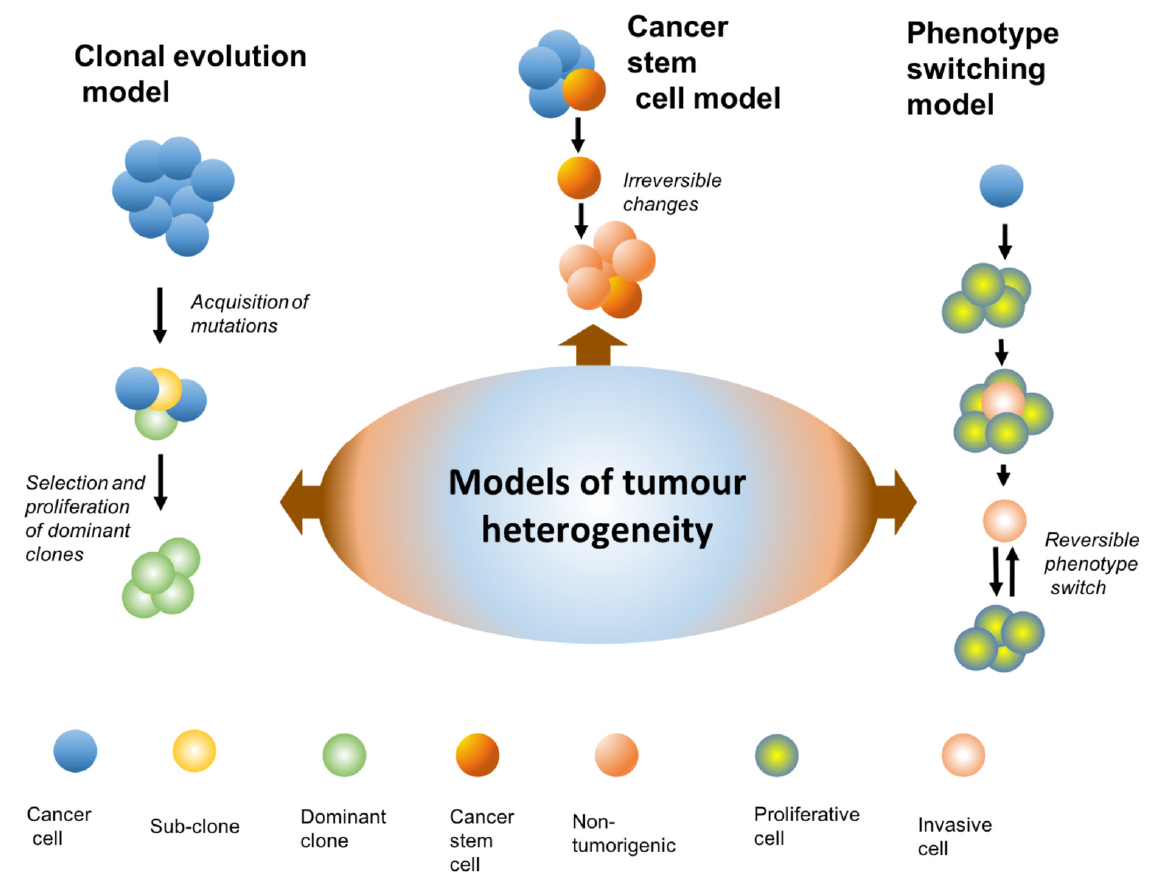
Figure 4. Models of the tumour heterogeneity. The clonal evolution was the first model. In this model the cancer cells evolve progressively due to genetic changes. The genetic instability produces many variants. Most variants die due to metabolic or immunologic disadvantage. The variants that have a selective advantage become the dominant sub-population until an even more favourable variant appears. Over time there is sequential selection of sub clones through evolutionary selection. The cancer stem cell model proposes that tumour heterogeneity arises because cancer cells give rise to stem cell-like cells which have a capacity to self-renew and differentiate into multiple cell types, just like the normal stem cells. The daughter cells of cancer stem cells are unidirectional and are not able to de-differentiate back into cancer stem cells. Hence, this model does not explain the plasticity represented by cancer cell subpopulations. The phenotype switching model is the most recently proposed model. This model shows a bidirectional relationship between cancer cell sub-populations. For details refer to the Figure